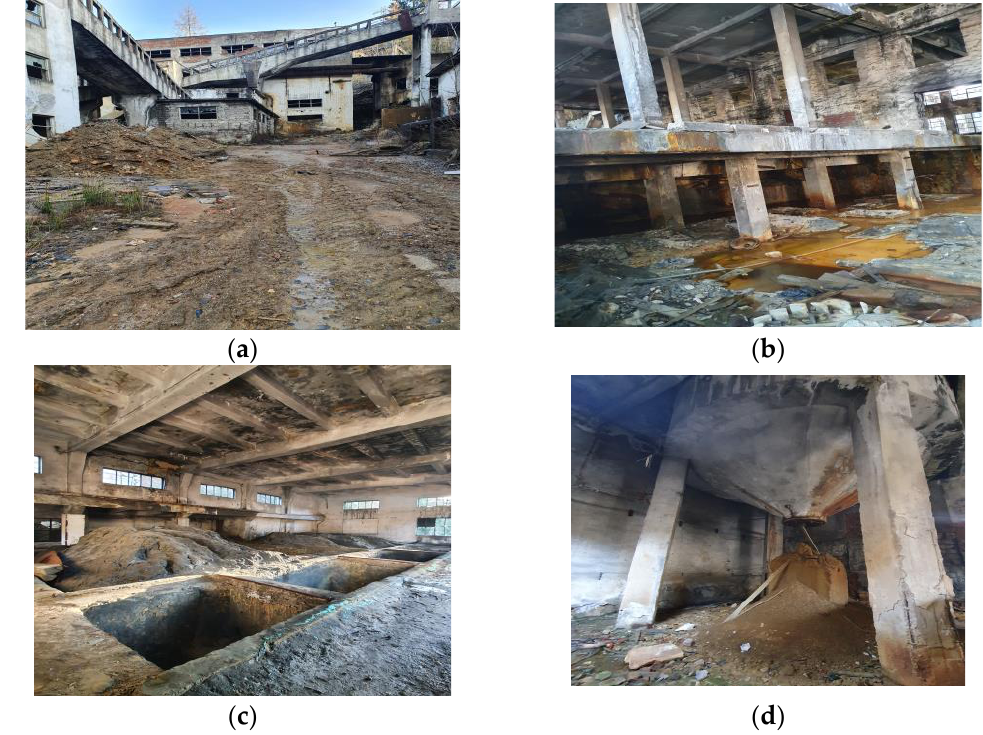
Figure 1. The ruins of the flotation treatment plant Băiuț with abandoned mining concentrate and sterile, Maramureș county, Romania (photos: I.A.P.): ( a ) Interior courtyard with sterile leaks; ( b ) Interior of building ruins of the treatment plant; ( c ) The platform of silos filling with mining concentrate; ( d ) Silo hopper and sterile mining.